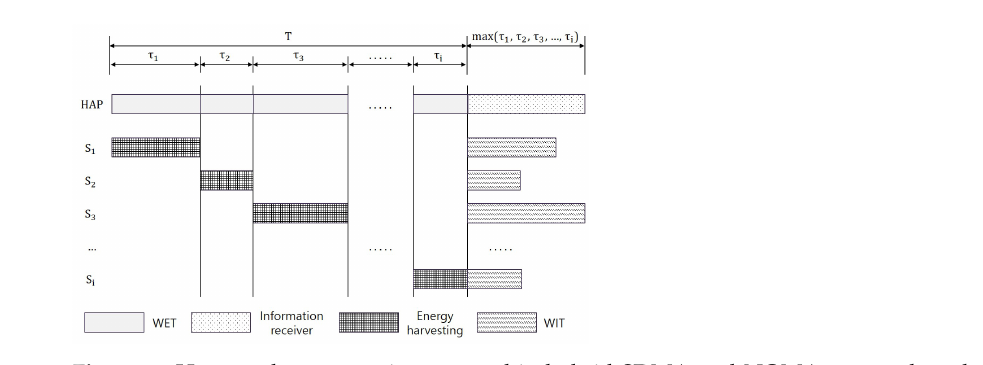
Figure 3. Harvest-then-transceive protocol in hybrid SDMA and NOMA approach and optimal power allocation.